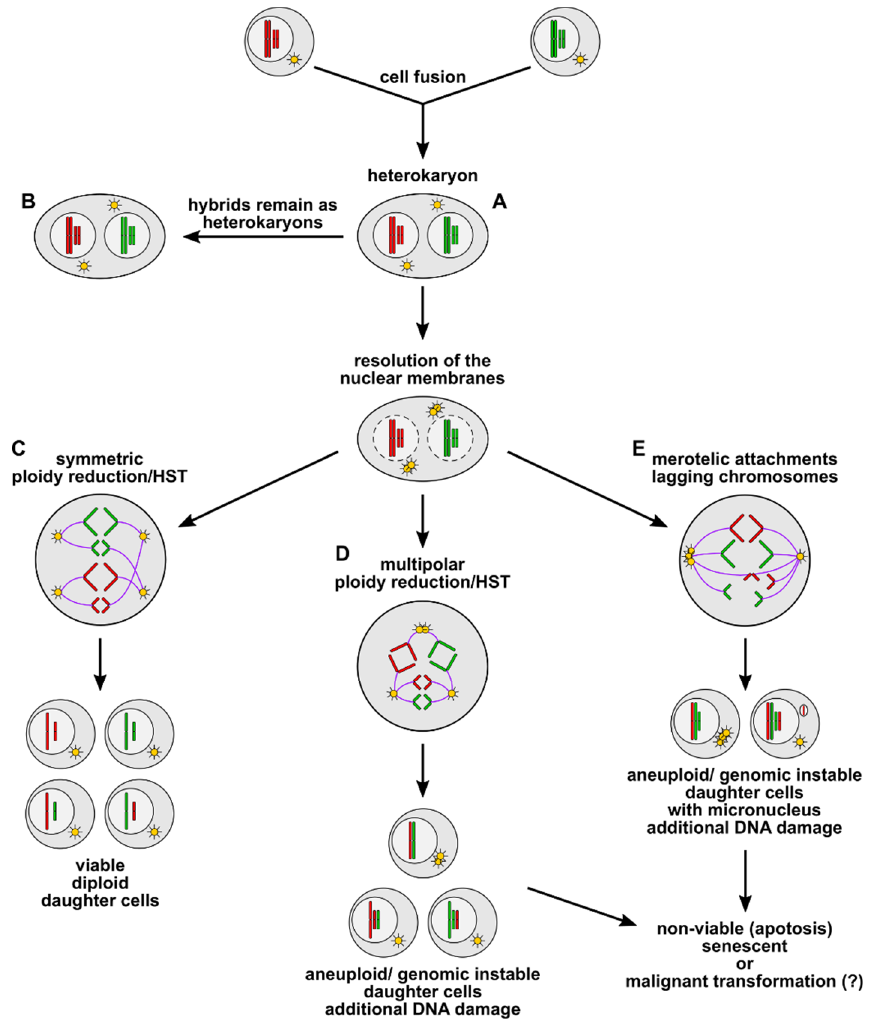
Figure 1. Cell fusion induced polyploidy, aneuploidy, and genomic instability. Cell fusion first results in the origin of bi- or multinucleated heterokaryons ( A ), which could either remain in this state ( B ) or could undergo ploidy reduction/heterokaryon-to-synkaryon transition (HST). Symmetric ploidy reduction/HST ( C ) gives rise to viable diploid daughter cells, whereby a random segregation of parental alleles to daughter cells can be possible. Multipolar ploidy reduction/HST ( D ) results in the origin of aneuploid/genomic unstable daughter cells, whereas merotelic attachments ( E ) during mitosis can cause lagging chromosomes and micronucleus formation in aneuploid/genomically unstable daughter cells. Aneuploidy/genomic instability concomitant with micronucleus formation is associated with further DNA damage, such as chromothripsis and translocations (not shown here). Most of these aneuploid/genetically unstable cells will be nonviable or will become senescent. However, it cannot be ruled out that some hybrid cells will survive and that aneuploidy/genomic instability concomitant with further DNA aberrations could ultimately lead to a malignant transformation of the cells.